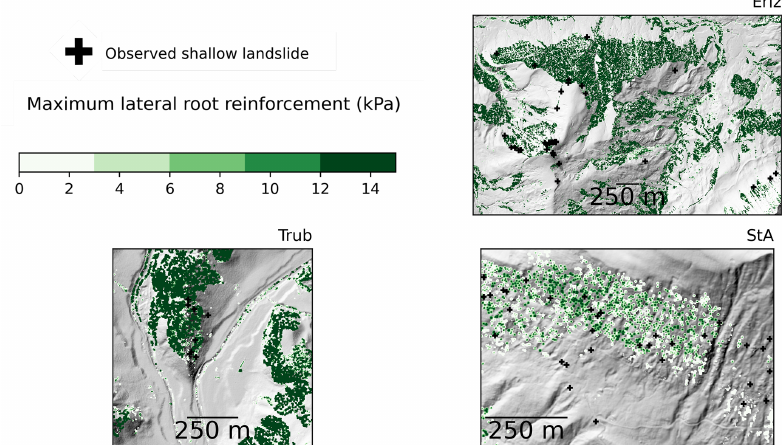
Figure 9. The spatial distribution of maximum root reinforcement (Eq. 8) in the study areas as used in SlideforMAP. Source of hillshade: Federal Office of Topography swisstopo (Swisstopo, 2018).